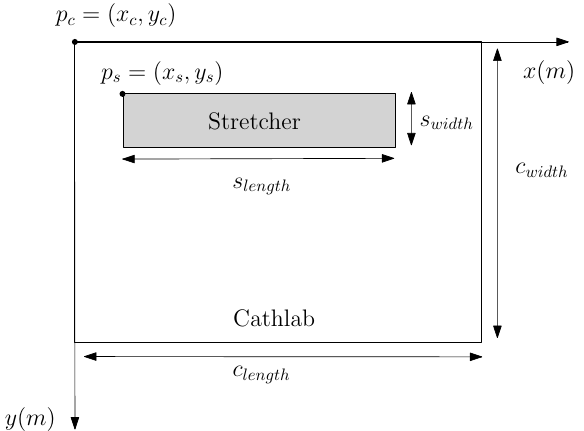
Figure 2. Top view of the CathLab: room and stretcher